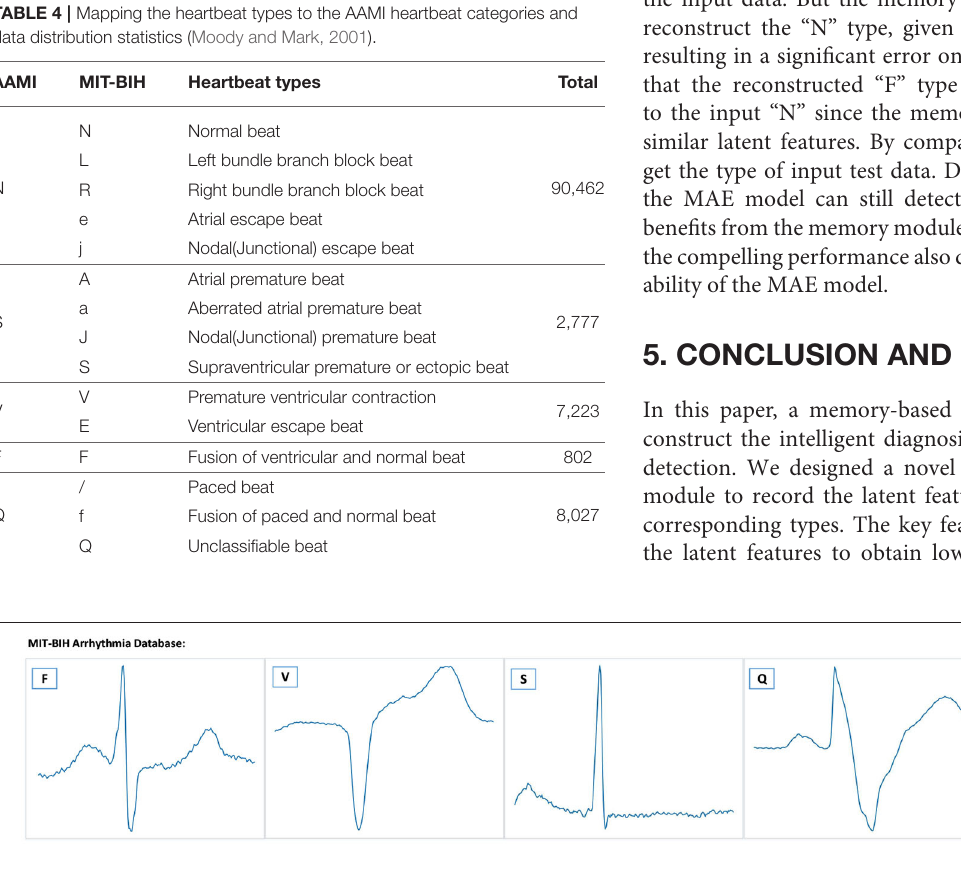
Frontiers in Physiology |